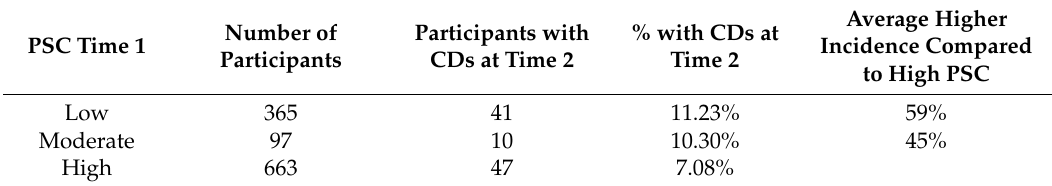
Table 2. PSC benchmarks and CDs